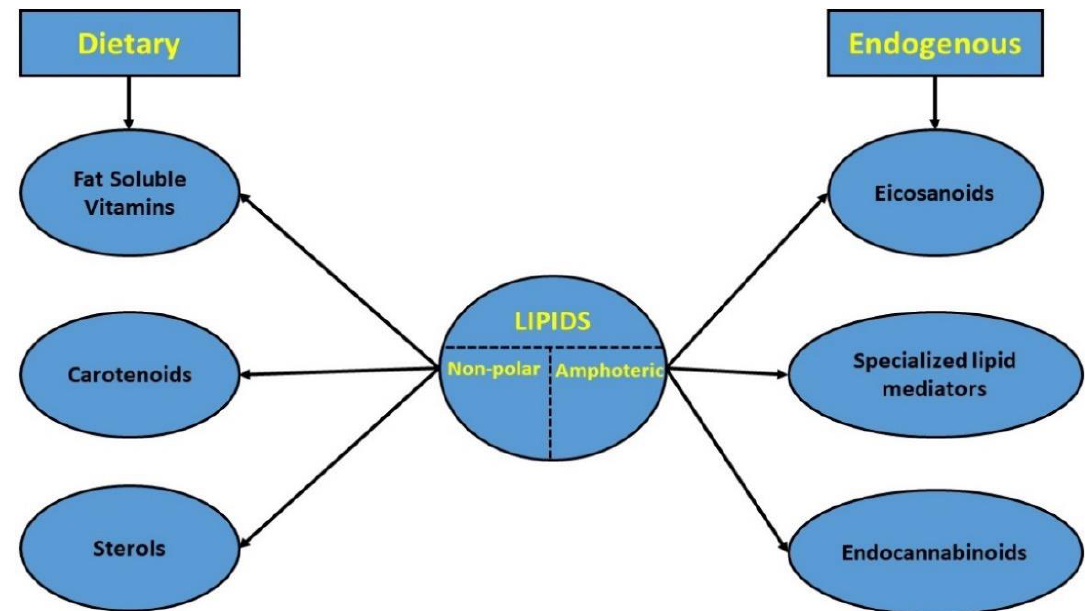
Figure 1. Classification of the studied lipid categories.